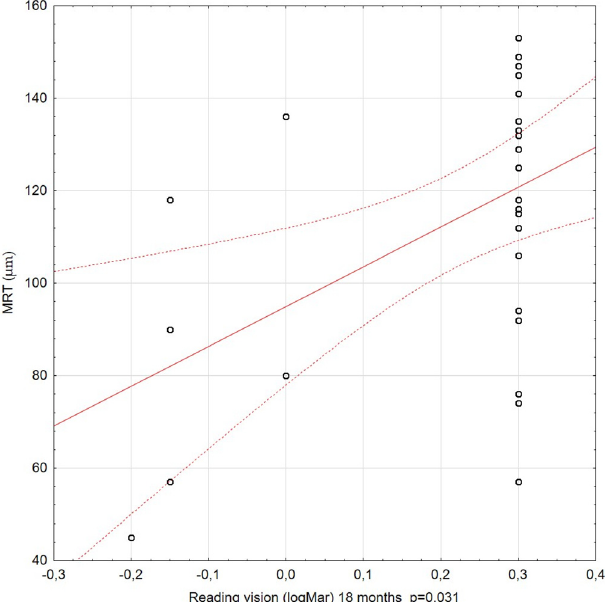
Figure 11. Correlation between reading vision (RV) (at 18 months) and minimal retinal thickness (MRT). A statistically significant correlation was observed: better RV correlated with higher MRT values.